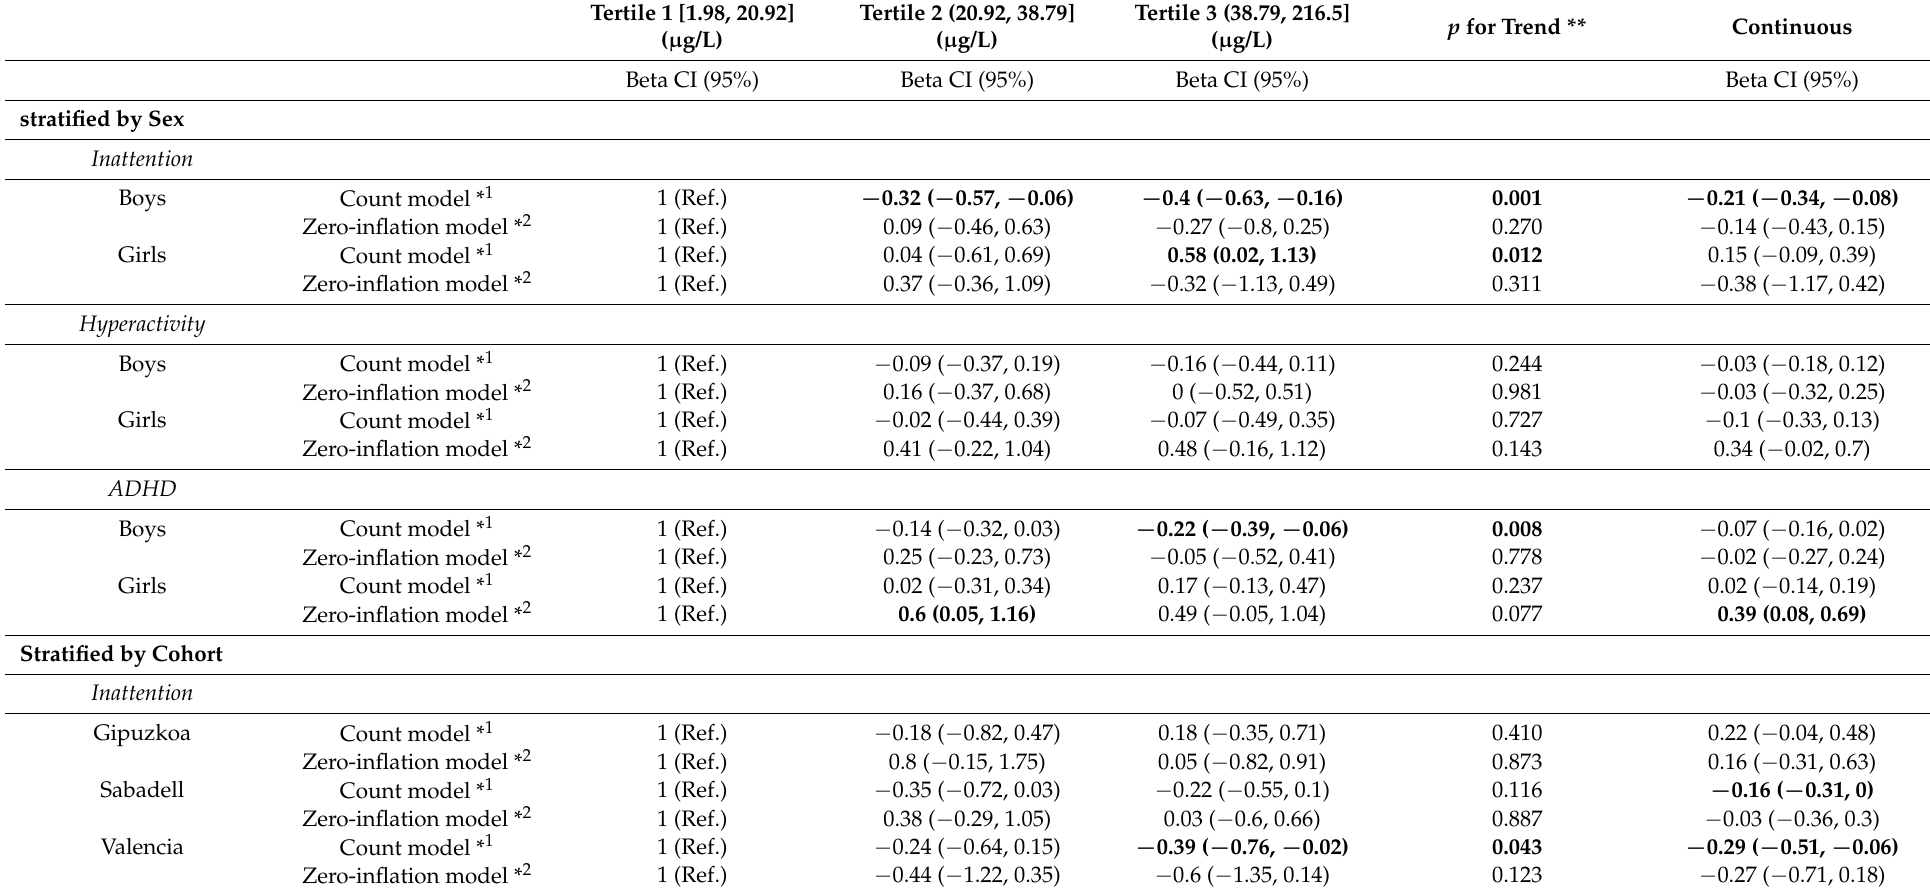
Table 4. Zero-inflated Poisson regression models for the association between inattention, hyperactivity, and ADHD symptoms with ferritin levels (log